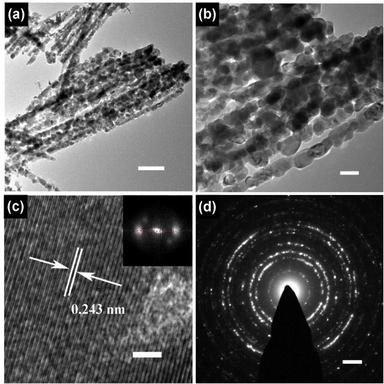
(a and b) TEM images of the MgCo2O4 nanoneedle arrays, scale bar ¼ 200, 50 nm. (c) HRTEM images of the MgCo2O4 nanoneedle arrays, scale bar ¼ 30 nm. (The inset is a Fourier image of this HRTEM image calculated using Fourier transform.) (d) SAED pattern of the MgCo2O4 nanoneedle arrays, scale bar ¼ 20 nm.